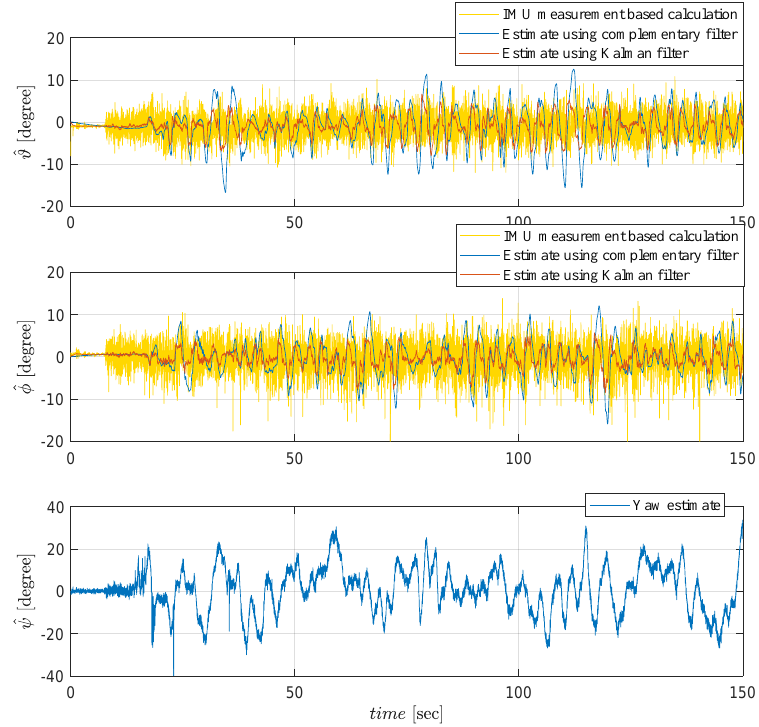
Figure 8. Attitude estimation of the Qball-X4.